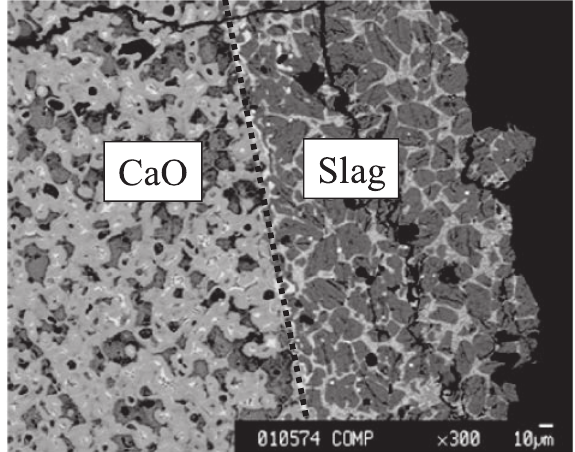
Fig. 12: Cross sectional image of interface between lime and slag when sintered lime (s-Lime) dipped into FeO-CaO-B